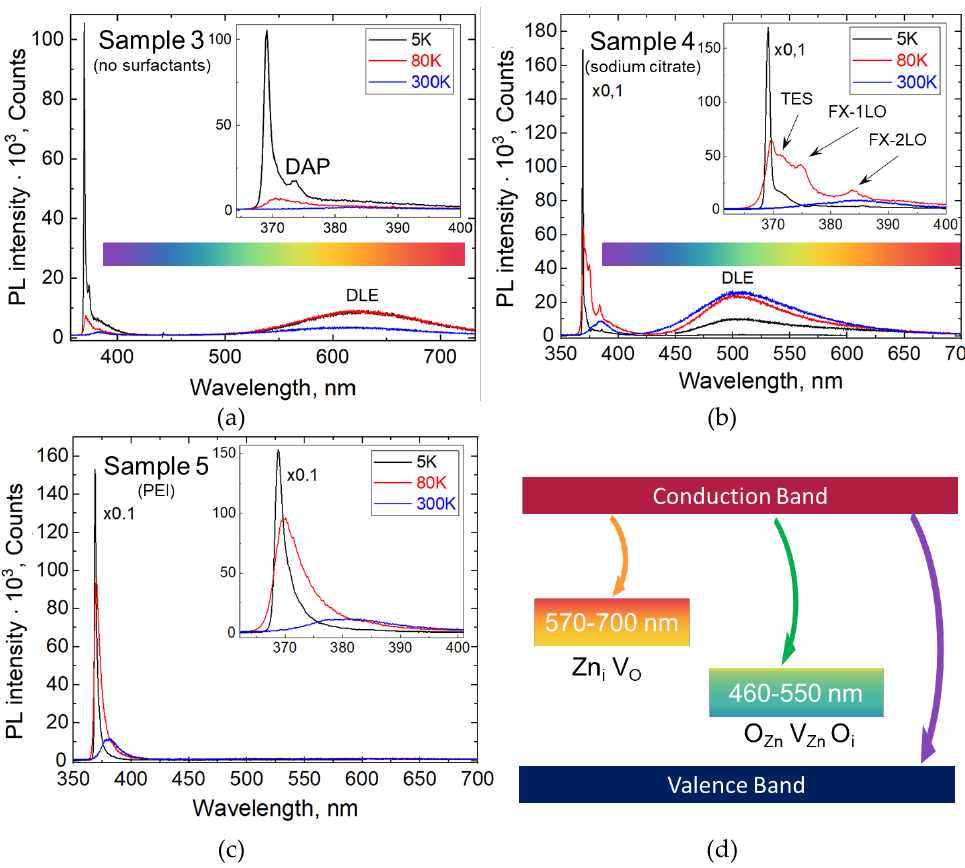
Figure 5. PL spectra taken in a wide spectral range at different temperatures: ( a ) Sample 3 (without surfactant), ( b ) Sample 4 (with sodium citrate), NBE region of the spectrum is multiplied by 0.1, ( c ) Sample 5 (with PEI) NBE region of the spectrum multiplied by 0.1. Insets ( a – c ): enlarged short-wavelength region of the PL spectra. ( d ) Schematic representation of the deep levels and corresponding radiative transitions.